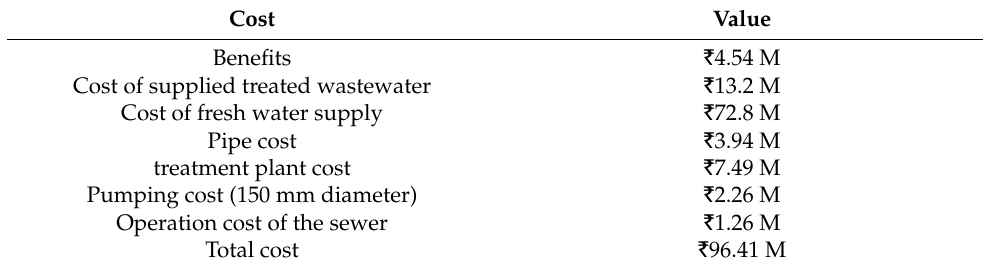
Table 6. Annual cost split up for implementation of decentralized wastewater reuse: network in Figure